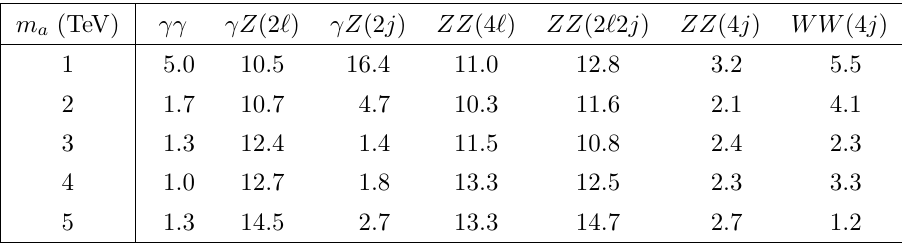
Table 4 . Percentage variations of the signal efficiencies for different search channels, based on models listed in table 3. The percentage variation is defined as the standard deviation of signal efficiencies divided by the mean signal efficiency of all the models we